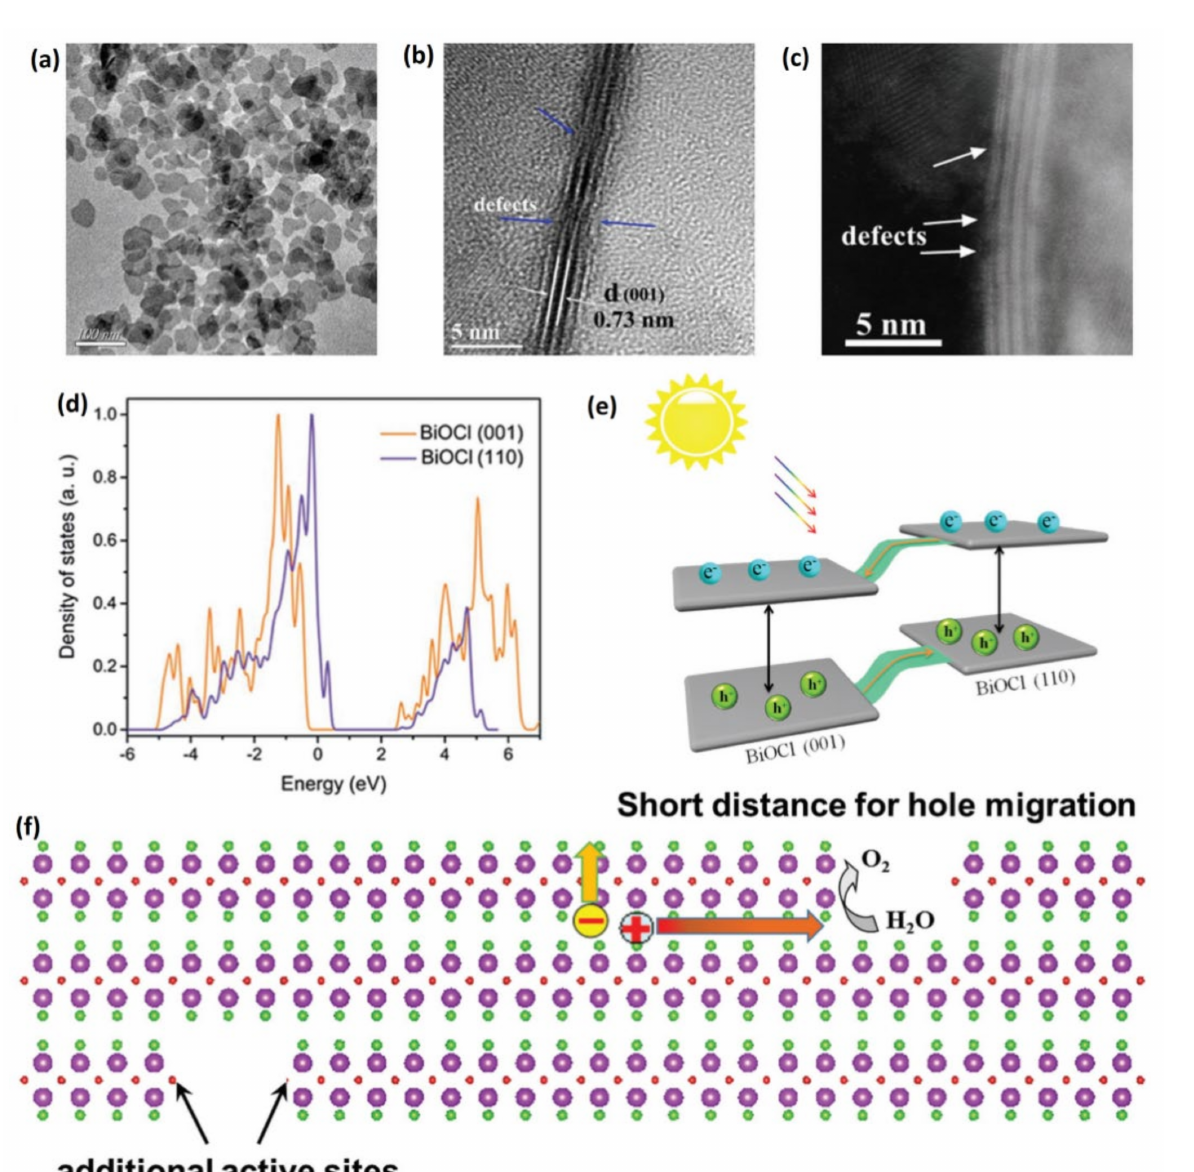
Figure 4. ( a , b ) TEM photograph and ( c ) HAADF-STEM images BiOCl nanosheets with defects; ( d ) DOS diagrams of BiOCl (001) and (110) faces from first-principles simulations; ( e ) charge migration between 001 and 110 facets is shown in this diagram; ( f ) photogenerated charges are separated and transferred in this schematic illustration. Adapted from [65] Copyright 2017, The Royal Society of